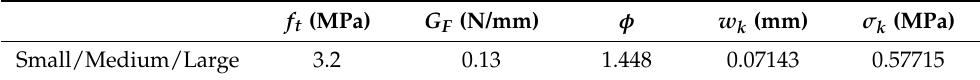
Table 4. Intermediate values for obtaining point k of the trilinear diagram.